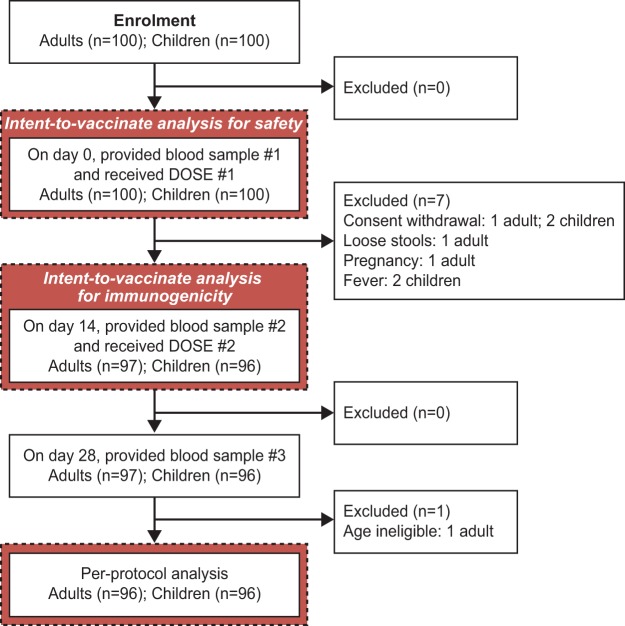
Summary of the flow of participants through the study.